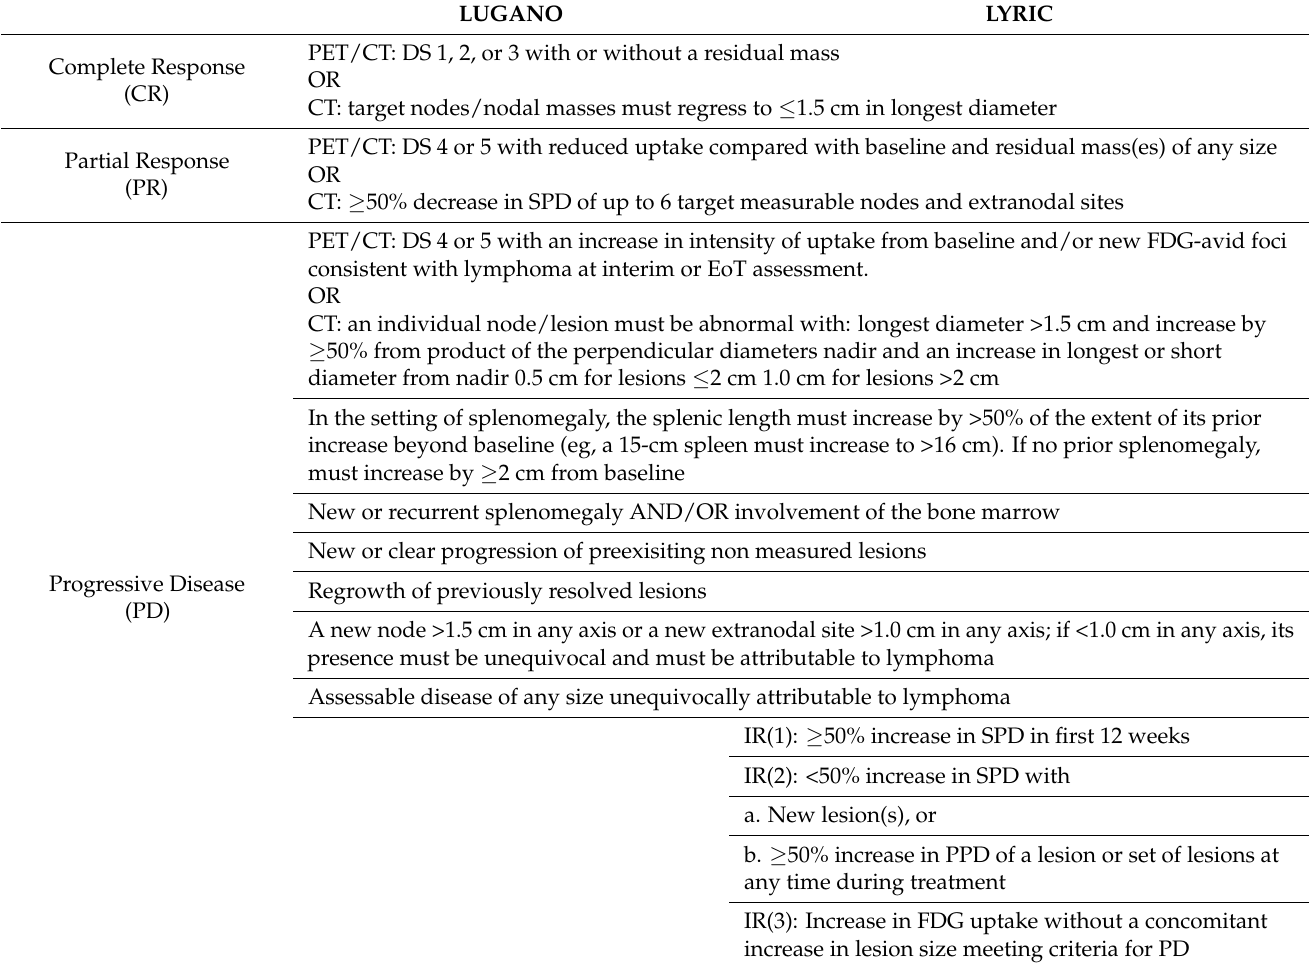
Table 1. LUGANO and LYRIC (Lymphoma Response to Immunomodulatory therapy Criteria) imaging interpretation